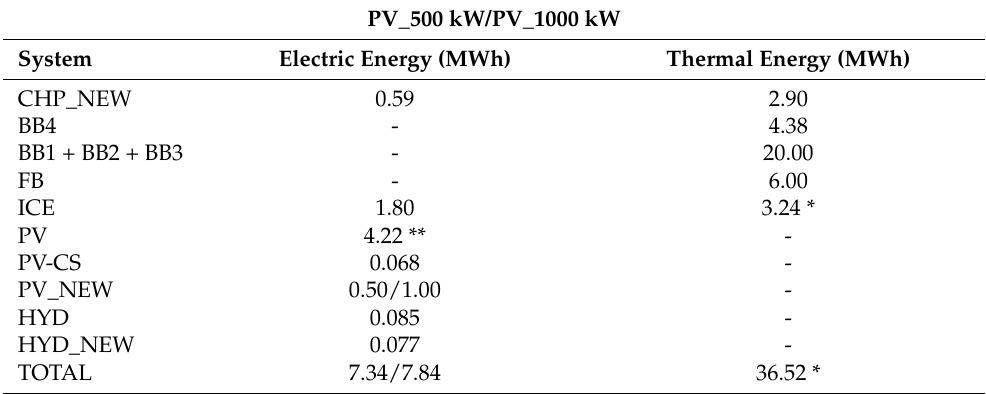
Table 7. Nominal thermal and electric power of the energy conversion systems included in the REC of